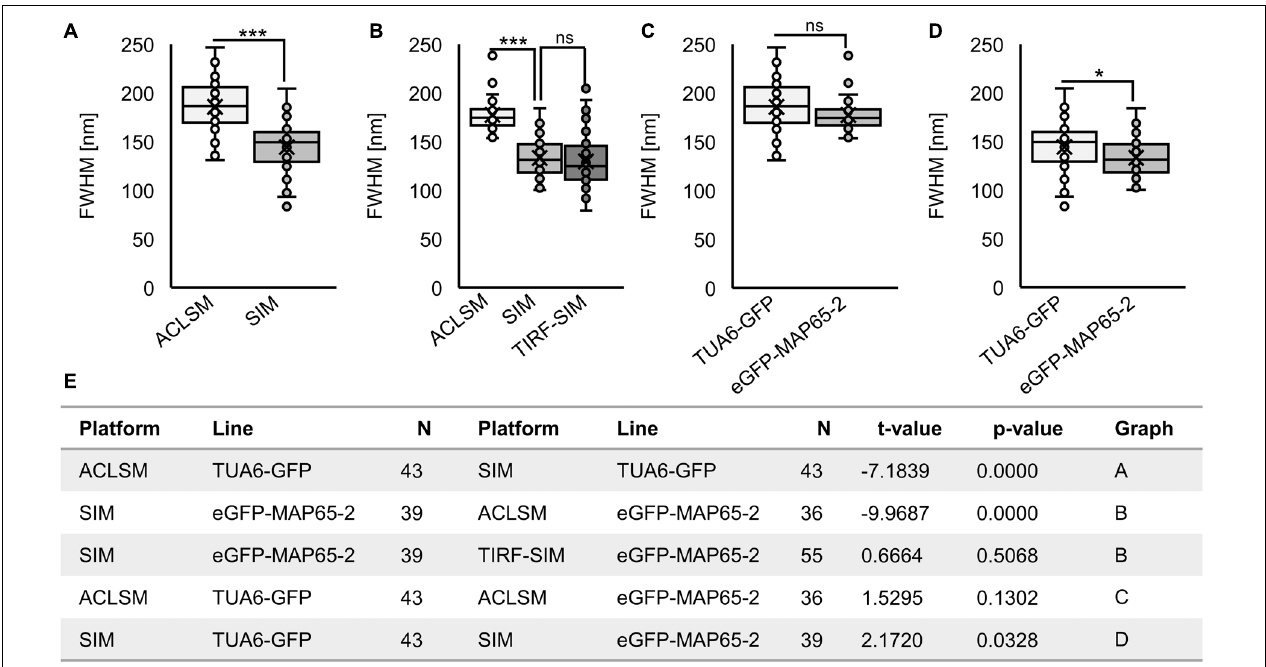
FIGURE 3 | Quantitative analysis of resolution achieved by using ACLSM, SIM, and TIRF-SIM in resolving details of cortical microtubules (MTs) with TUA6-GFP marker or eGFP-MAP65-2 decoration of cortical MTs. Boxplots present the full-width at half maximum values (FWHM). (A) Comparison of ACLSM and SIM in resolving MTs with TUA6-GFP marker. (B) Comparison of ACLSM, SIM, and TIRF-SIM in resolving eGFP-MAP65-2 decoration of MTs. (C) Resolution reached by ACLSM for either TUA6-GFP or eGFP-MAP65-2. (D) Resolution reached by SIM for either TUA6-GFP or eGFP-MAP65-2. (A–E) Unpaired two-sample t -tests were used for statistical analysis (*** significant at p 0.001, * significant at p 0.05, ns, not statistically significant) and the results are in (E) . Description of box plot: average is presented by × , median by the middle line, 1st quartile by the bottom line, 3rd quartile by the top line; the whiskers lie within the 1.5 × interquartile range (defined from the 1st to the 3rd quartile), outliers are marked by